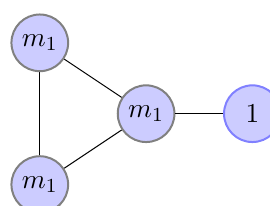
Figure 17 . The mirror quiver obtained after performing the Coulomb branch (cid:13)ow from (cid:12)gure 14 described in the main text. Nodes and lines are de(cid:12)ned as in (cid:12)gure 11.